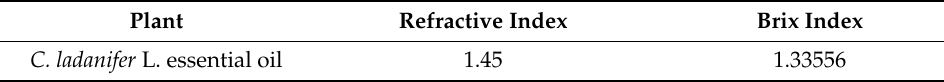
Table 1. Refractive index and Brix index of the C. ladanifer essential